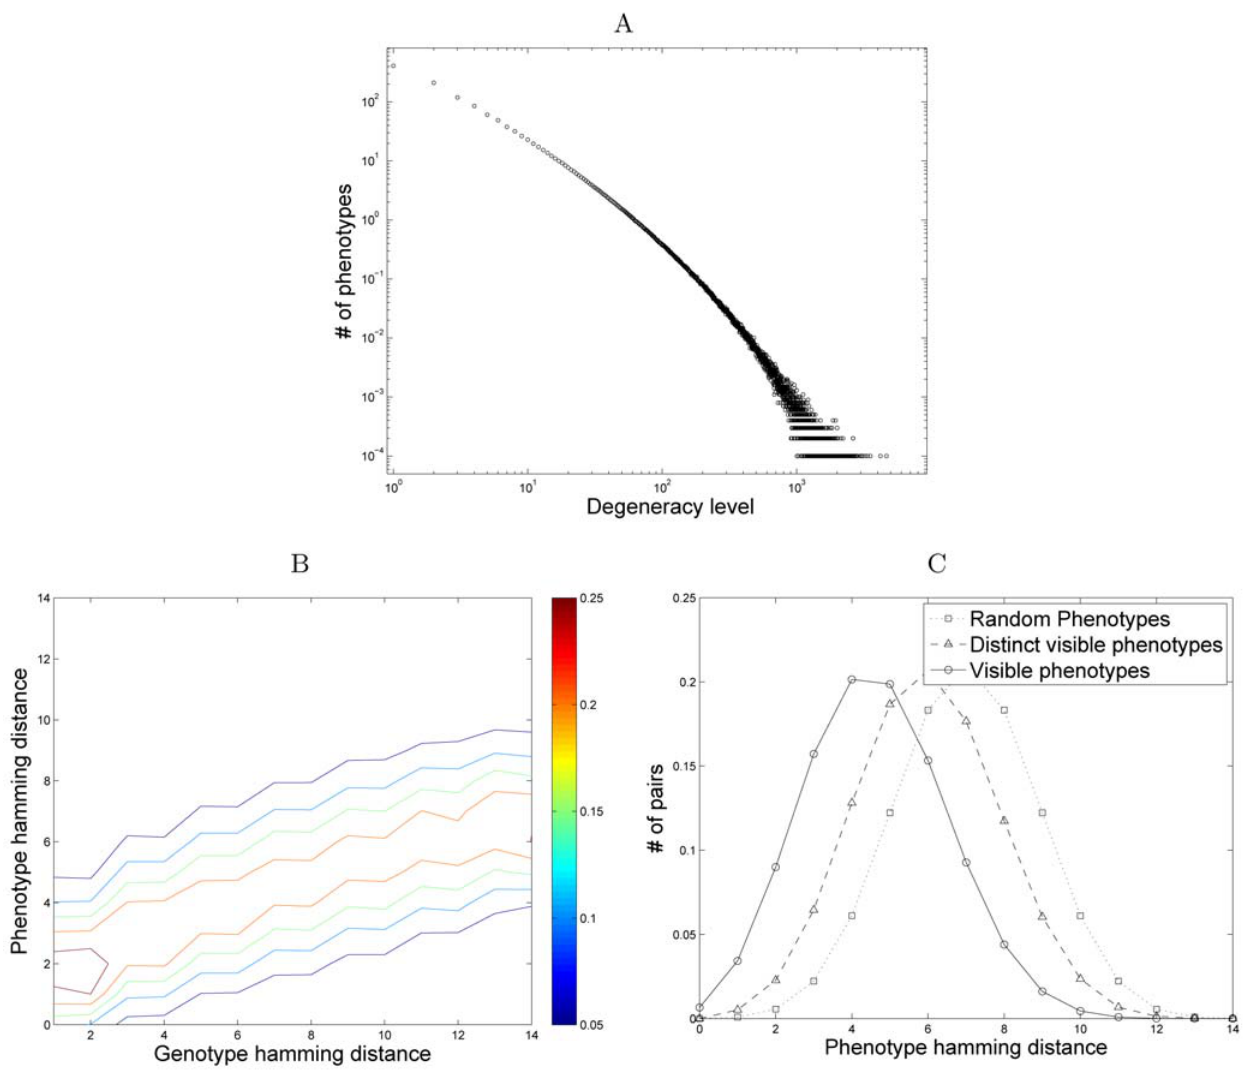
Figure 3. Localization of the visible phenotypic subspace. (A) A loglog plot of the distribution of degeneracy levels among visible phenotypes. Each point denotes the expected number of distinct phenotypes with a certain degeneracy level for a given developmental plan and is an average over 10,000 different plans. Note that the point associated with degeneracy level 0 (i.e., hidden phenotypes) is not included. These developmental plans frequently give rise to phenotypes with degeneracy levels higher than 10 3 , and in rare cases, higher than 10 3.5 . Given that the total number of genotypes is 2 14 a single phenotype can be produced by 6%–20% genotypes. (B) A contour plot of the gain function induced by a given developmental plan (all developmental plans produce qualitatively similar results). The gain function, gain ( d g , d p ), denotes the probability that the Hamming distance between two phenotypes is d p , given that the distance between the two genotypes that produced them is d g . (C) The distribution of pairwise phenotypic Hamming distances among randomly selected phenotypes (not produced by a developmental plan), distinct visible phenotypes (considering every visible phenotype only once, regardless of frequency), and visible phenotypes including all occurrences of each phenotype. The pairwise Hamming distances between randomly selected phenotypes follows a binomial distribution, with mean distance 7 (for phenotypes of length 14). Distinct visible phenotypes are closer to one another, with the mean distance 5.976. When weighting by the frequency of the visible phenotypes, the distance is reduced, with a mean distance